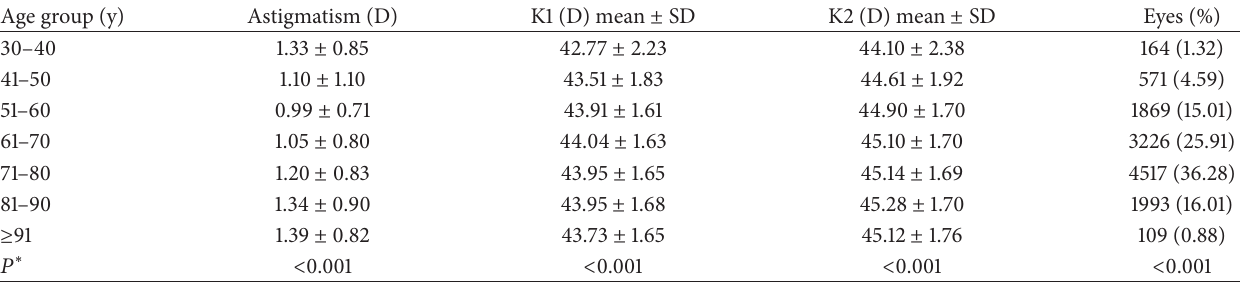
Table 2: Descriptive statistics by age group.